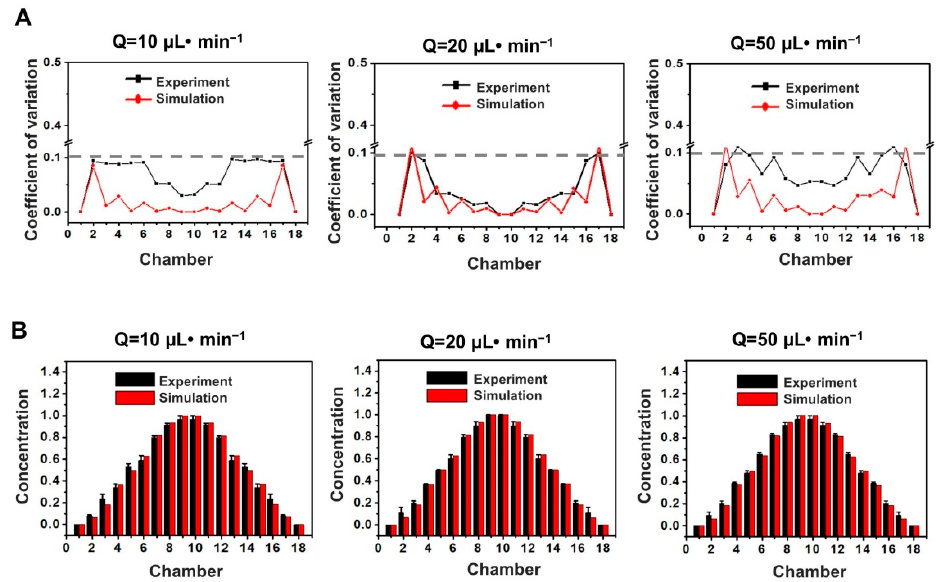
Figure 4. Quantitative gradients characterization in each microchamber under different flow rates of 10 μ L·min − 1 , 20 μ L·min − 1 , and 50 μ L·min − 1 . ( A ) Experimental and computer-simulated coefficient of variation (CoV) values in 18 microchambers. ( B ) Experimental and computer-simulated concentration values in 18 microchambers. Standard deviations deduced from 10 parallel experiments are shown as the error bars. Scale bar, 500 μ m.